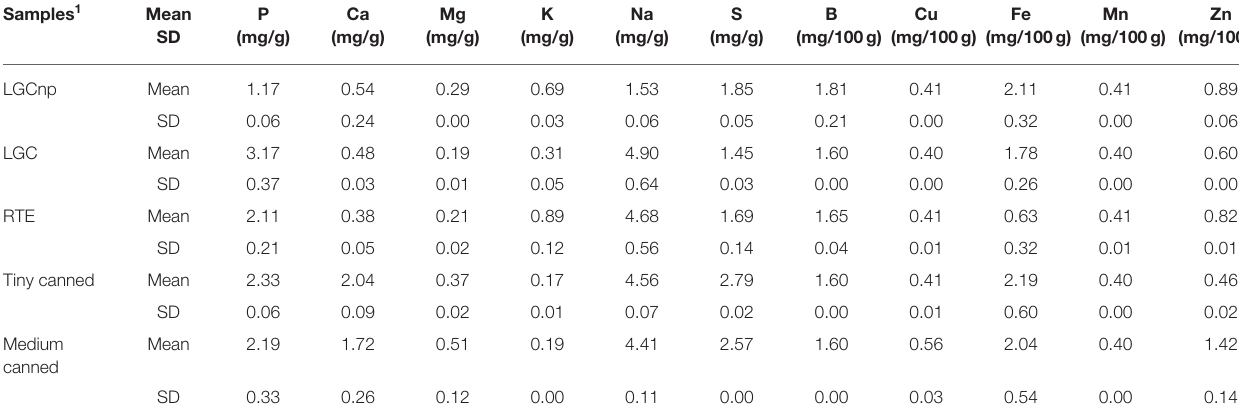
TABLE 4 | ICP-OES mineral analysis of the retort-processed and non-retort-processed shrimp. Samples 1